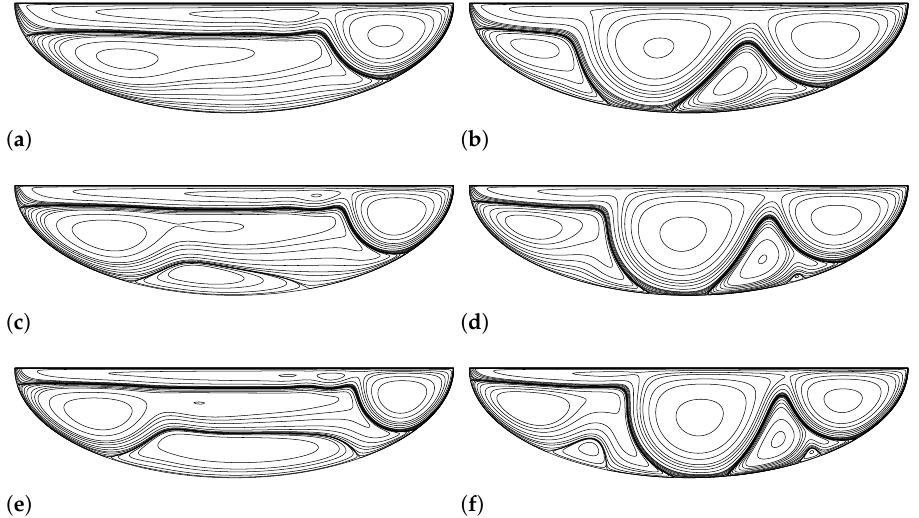
Figure 6. The 1st and 2nd solutions of driven semi-elliptical cavity flow with D = 0.5 aspect ratio at various same Reynolds numbers. ( a ) Re = 6000 (1st solution). ( b ) Re = 6000 (2nd solu- tion). ( c ) Re = 10,000 (1st solution). ( d ) Re = 10,000 (2nd solution). ( e ) Re = 14,000 (1st solution). ( f ) Re = 14,000 (2nd solution).